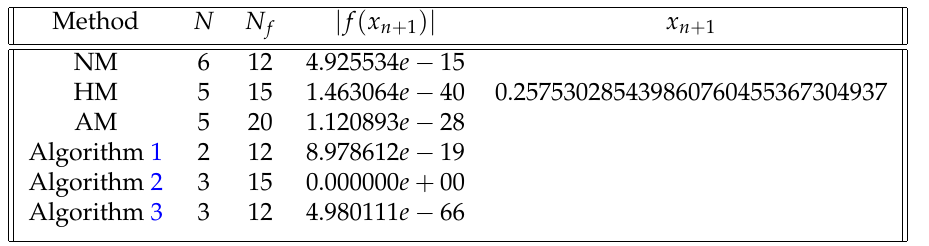
Table 4. Comparison of NM, HM, AM and Algorithms (1), (2) and (3) .